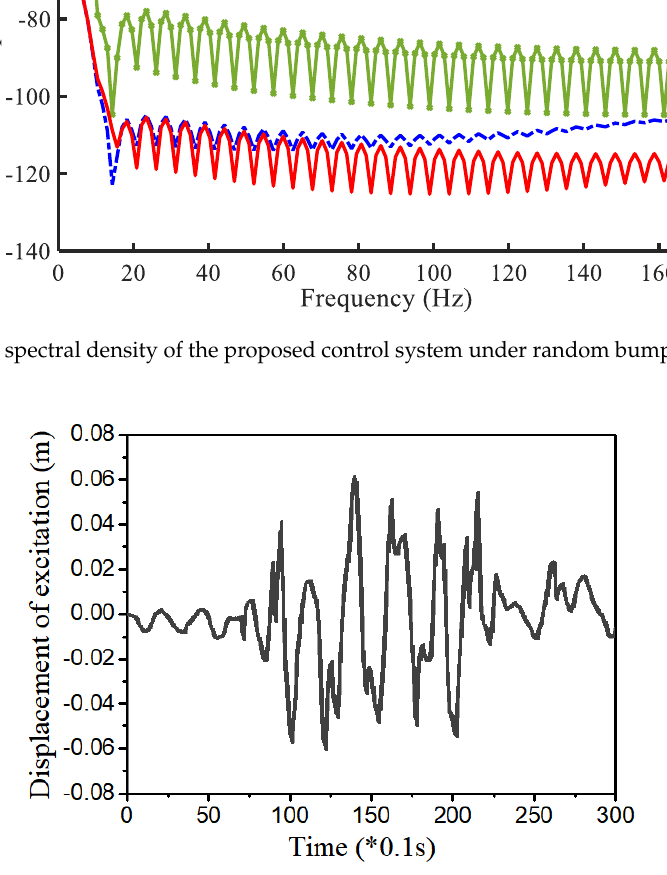
Figure 13. Random step wave road excitation.